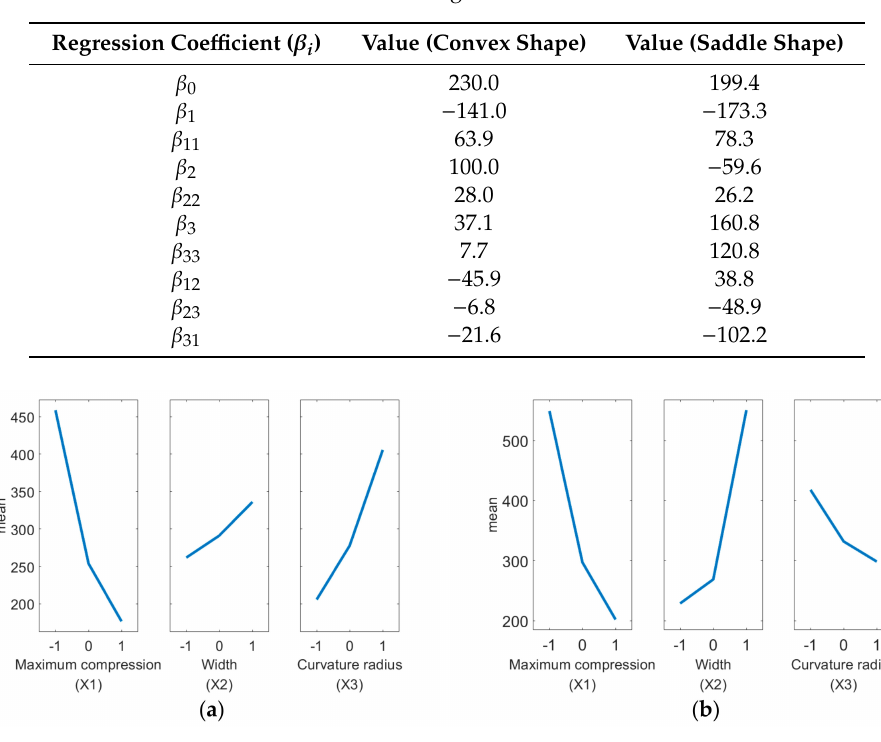
Figure 6. Plots of the main e ff ects of the design variables. ( a ) Convex shape and ( b ) saddle shape.